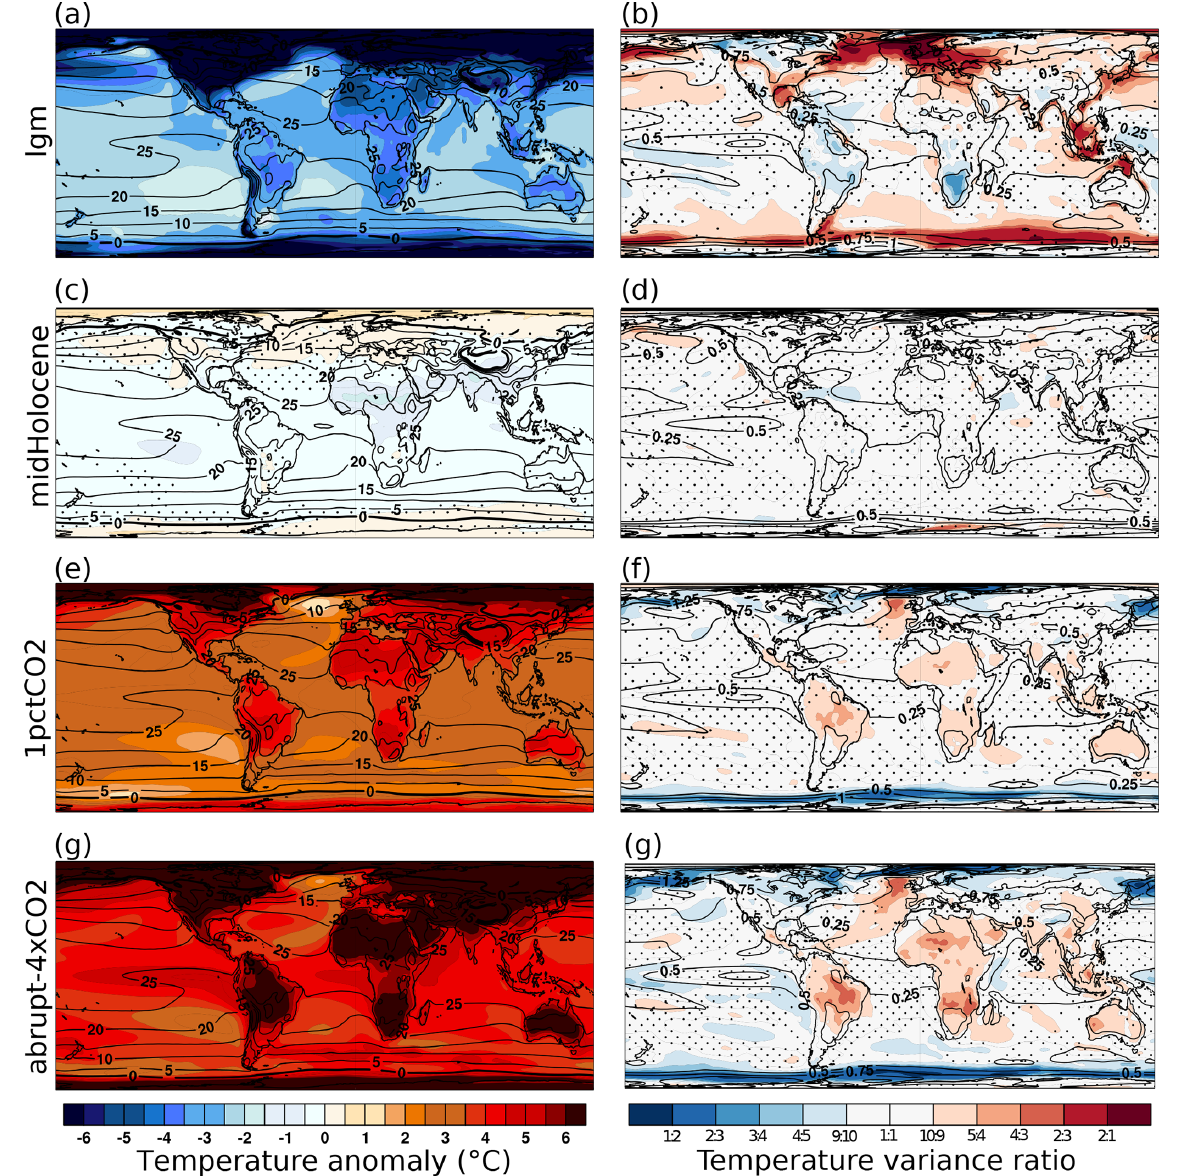
Figure 2. The change in mean annual temperature (a–d) and its variability (e, f) across multiple climate experiments. Each panel shows the ensemble average difference. The changes in the mean temperature are calculated as the experiment minus preindustrial control grid box annual means. The changes in variability are given based on the ratio of the standard deviation of annual mean temperature in the experiment to that of the piControl experiment. Ratios above 1 indicate higher variability in the experiment than in the piControl. The contours in each panel show the ensemble mean pattern in the preindustrial control. Contour variations are due to the different number of models available for individual experiments, as the preindustrial ensemble mean is only computed from models in each experiment. Stippling indicates where the sign of the change disagrees for more than two-thirds of the